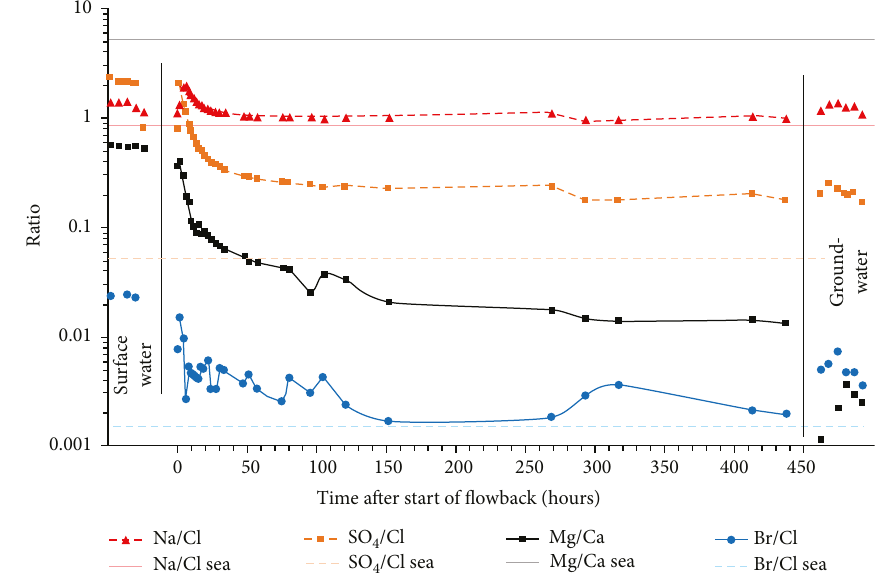
Figure 9: Variations in molar ionic ratios for the water produced from well PX-1 in August-September 2017, compared with equivalent ratios for seawater and for samples of the surface water used for injection (samples SK01-03 and SK20-21) and of groundwater previously recovered from well PX-1 (samples SK09-13 and SK19). Data for all samples are from the supplementary fi le. Calculations here and for Figure 10 use molar masses: Ca 2+ , 40.08 g; Mg 2+ , 24.305g; Na + , 22.99 g; Br - , 79.9g; Cl - , 35.453g; and SO 42- , 96.06g. Comparisons with seawater are based on